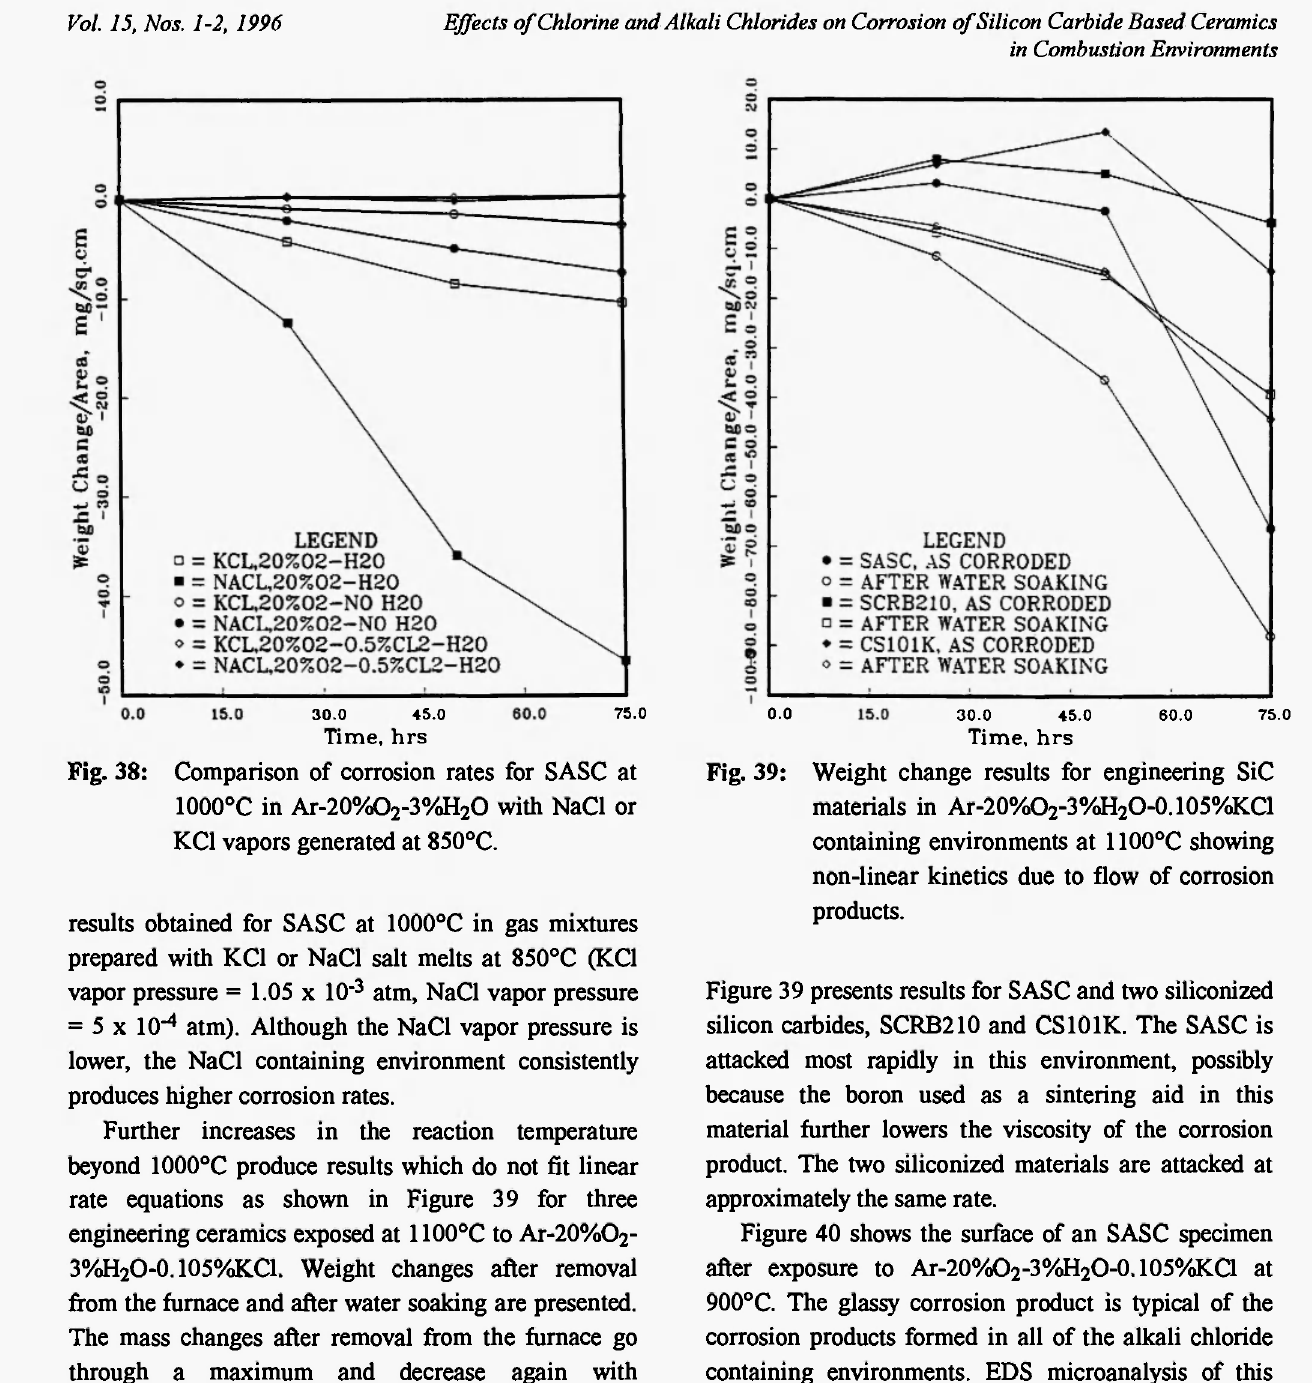
Fig. 38: Comparison of corrosion rates for SASC at 1000°C in Ar-20%0 2 -3%H 2 0 with NaCl or KCl vapors generated at 850°C.